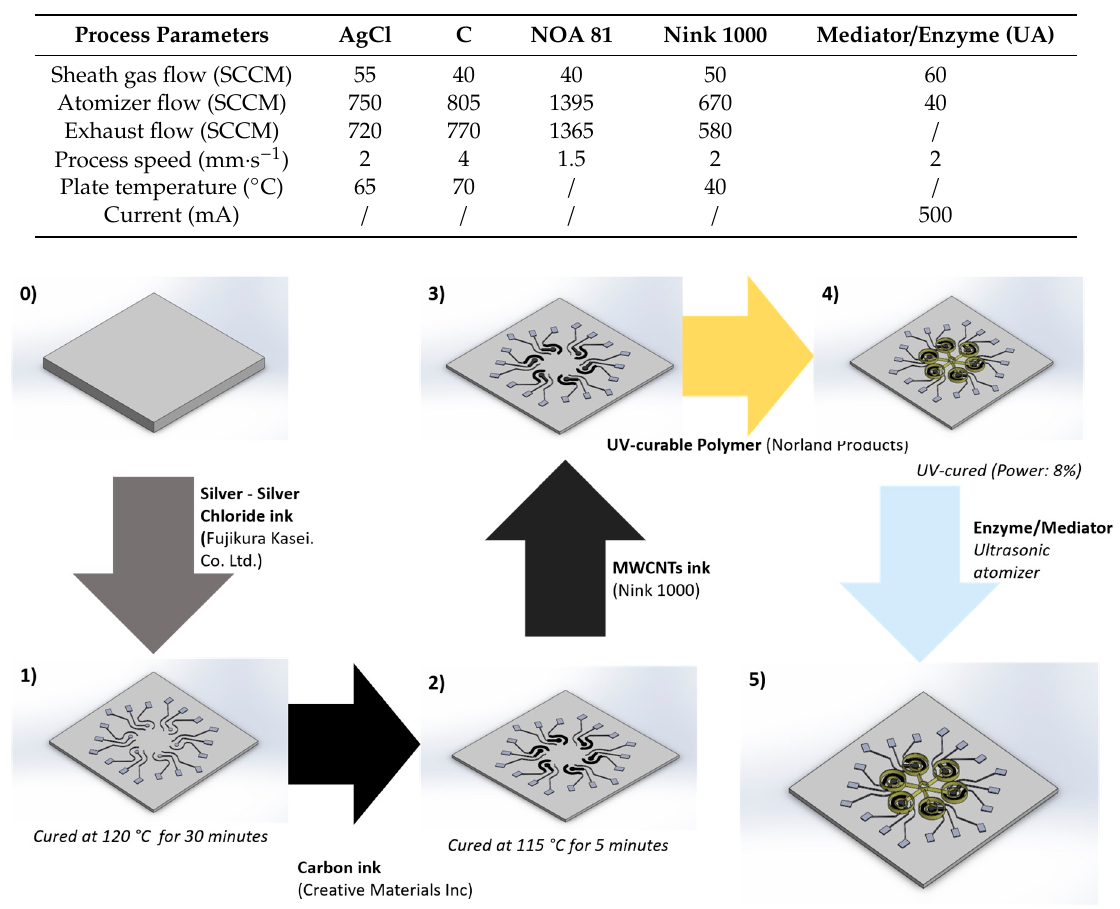
Table 1. Printing process parameters.